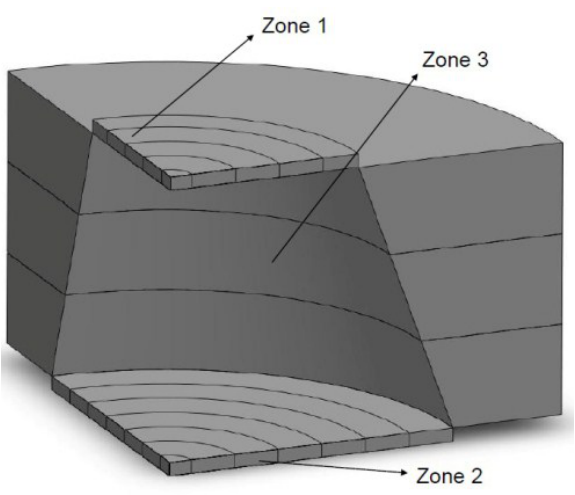
Figure 2. Example surfaces involved in radiation exchange in solar